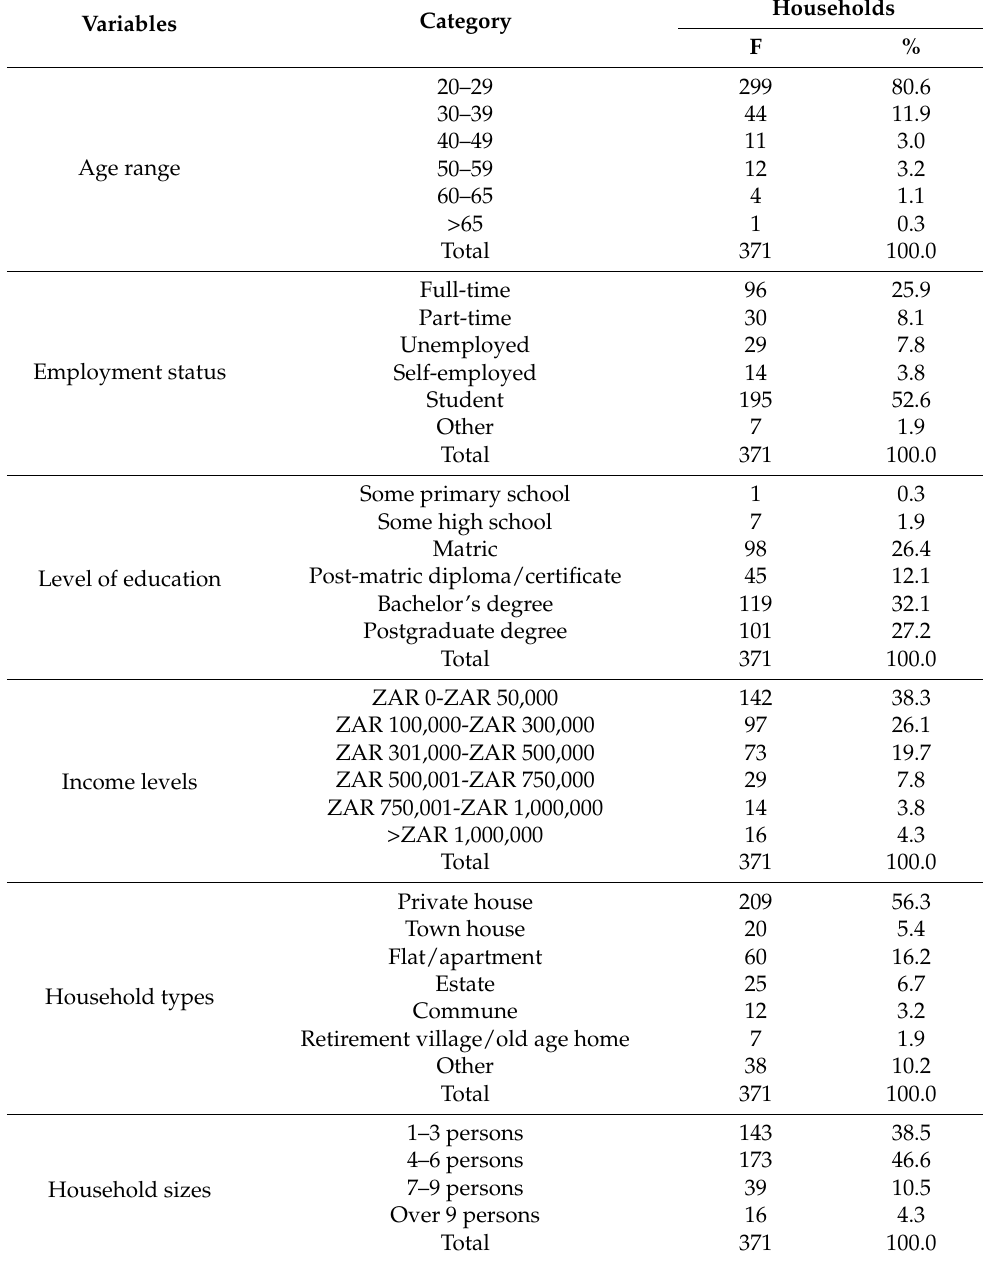
Table 1. The demographical characteristics of